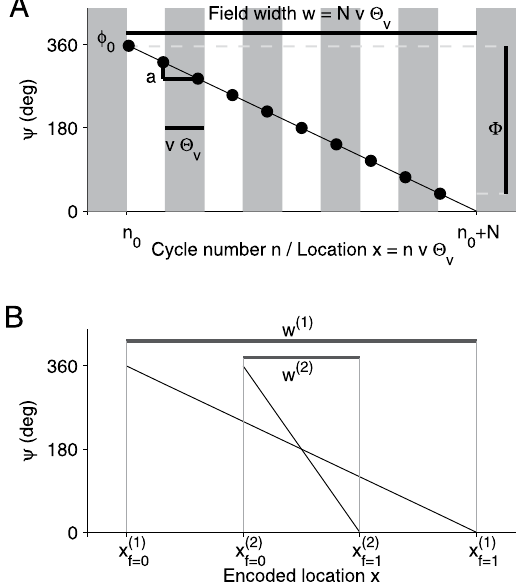
Figure 2. Nomenclature. ( A ) Spike phases ψ (black circles) decrease by a in each theta cycle (alternating grey and white patches). A field starts at theta cycle n 0 and ends at cycle n 0 + N (here N = 9). The start phase is denoted φ 0 , the total phase range is denoted by Φ < 0. The width w of the field is a result of the number N of theta cycles needed to cover the phase range. The spatial distance an animal covers in one theta cycle equals v Θ v , in which v denotes running speed and Θ v denotes the period length of a theta cycle in time. ( B ) To define a ordered sequence of overlapping place fields of different widths, we introduce the parameter f (fraction in the field), which identifies the field’s location in the sequence. For f = 0 (beginning of the field) the proposed sequential ordering of the two fields is 1 → 2, for f = 1 (end of the field) the ordering is 2 →